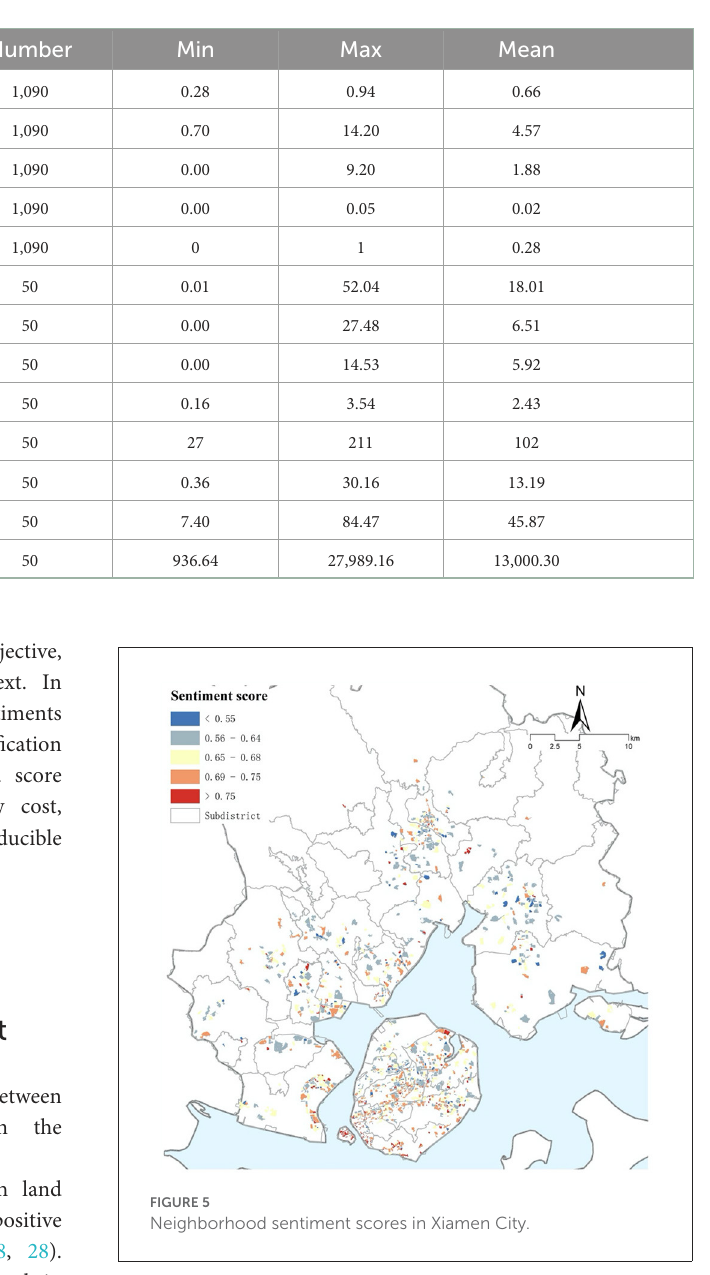
TABLE 3 Descriptive statistics of research variables.